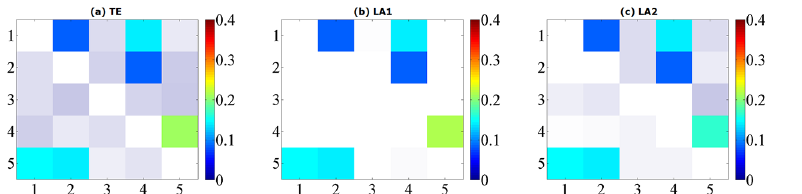
Fig 3. Matrix representations of the corresponding causalities for Model B. Retrieved by traditional TE method (a) and two low-dimensional approximation methods (b) (c) with linear estimator. The results are averaged over 100 simulations of 1024 time points and shown with color revealing the magnitude and transparency indicating the significance. The directions of causal influence are from row to column.